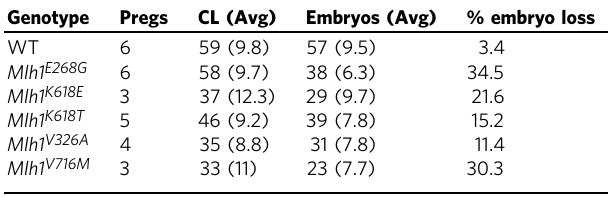
Table 3 Embryo loss during